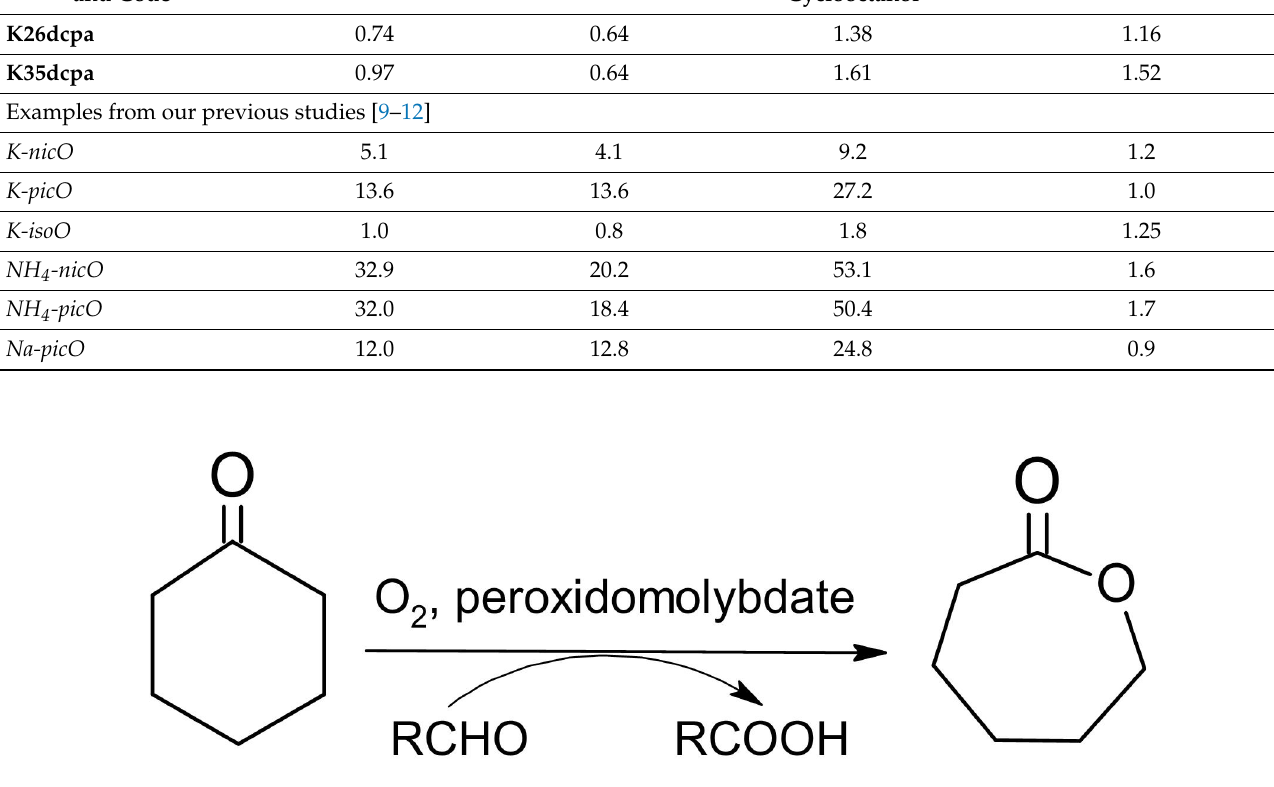
Figure 7. Scheme of catalytic Baeyer–Villiger (BV) cyclohexanone oxidation with molecular oxygen and peroxidomolybdates as catalysts. Table 7. Result of oxidation of cyclohexanone with molecular oxygen to ε -calprolactone.